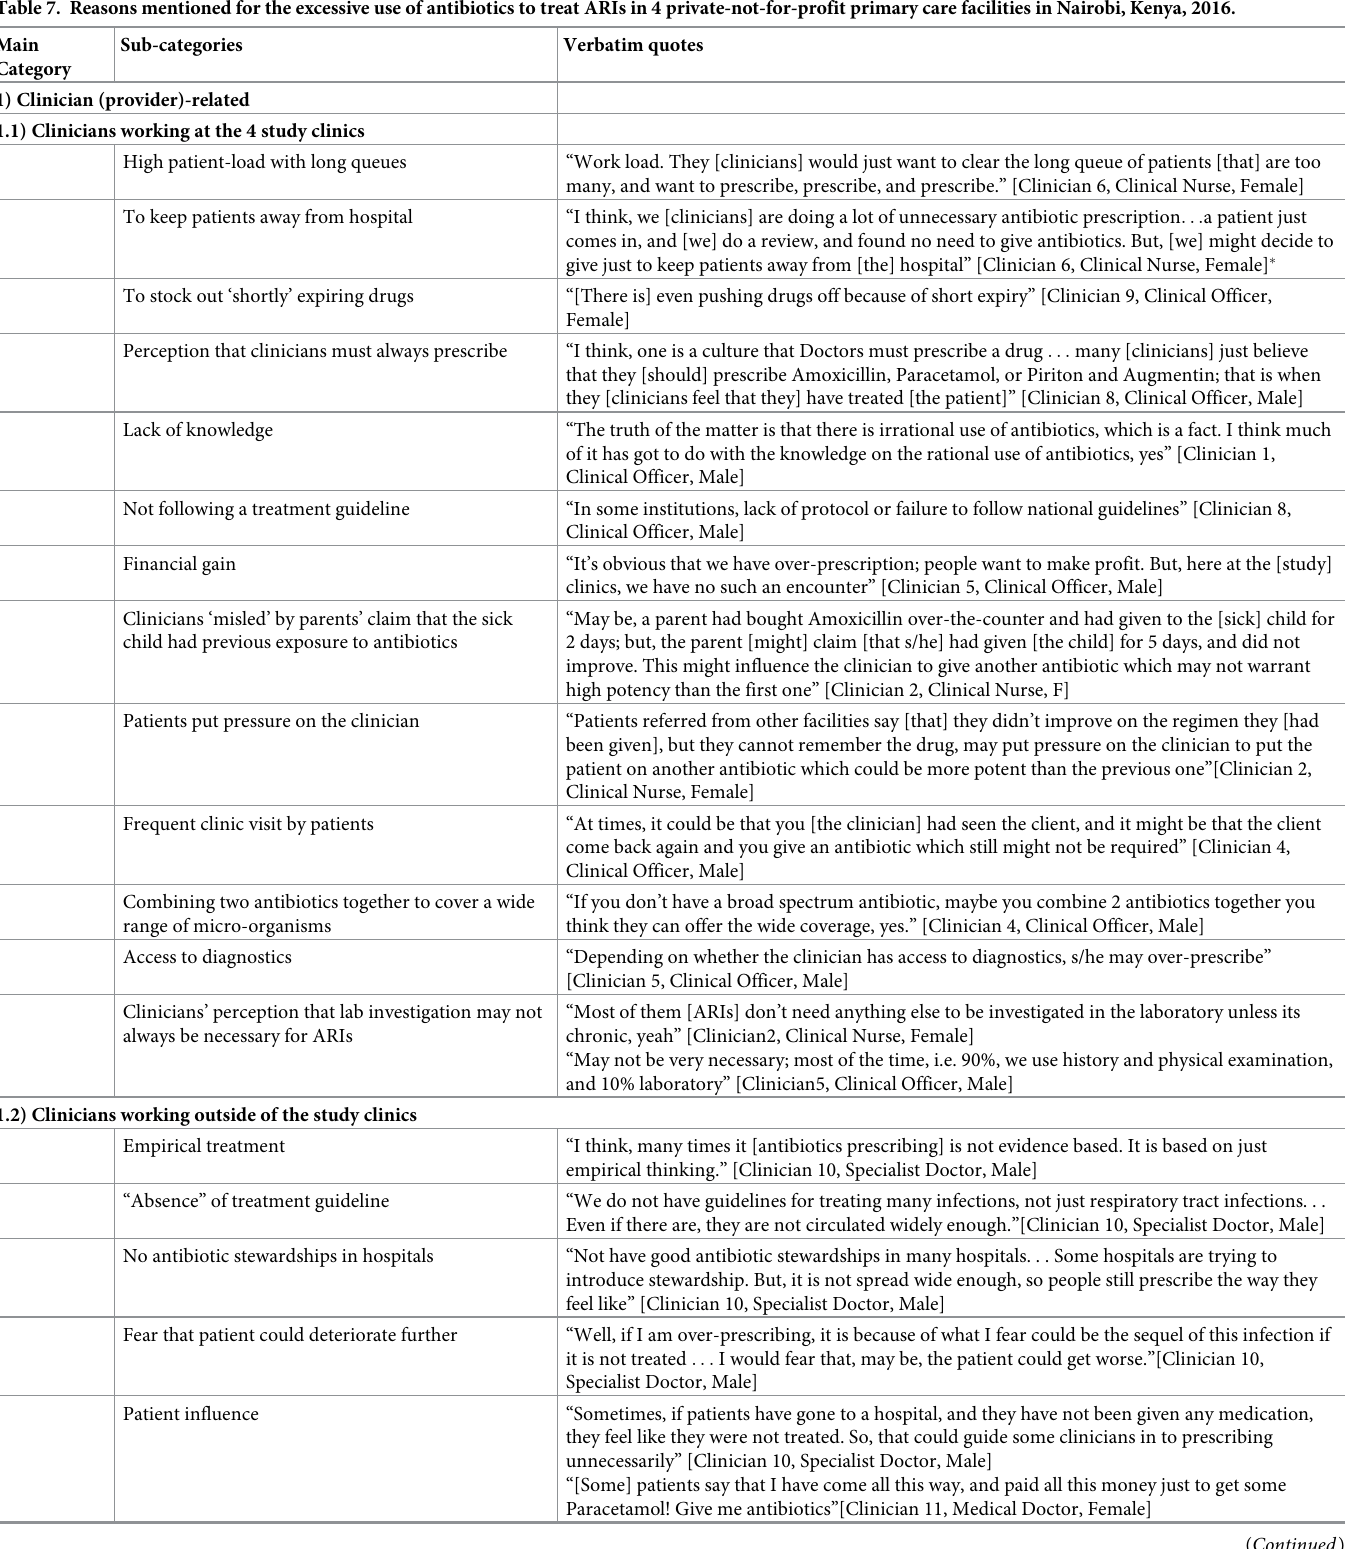
Table 7. Reasons mentioned for the excessive use of antibiotics to treat ARIs in 4 private-not-for-profit primary care facilities in Nairobi, Kenya, 2016. Main